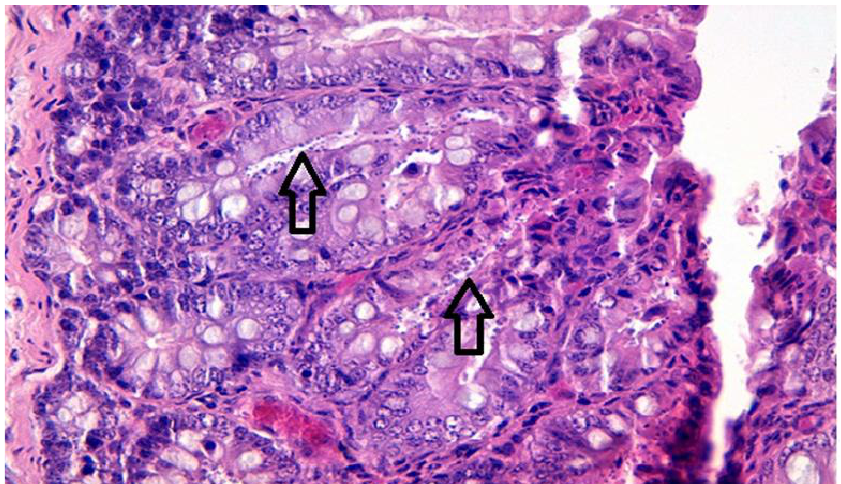
Figure 1. Fecal smear stained by the Ziehl Neelsen method. The smear shows a large number of oocysts belonging to the species C. parvum . The high density of oocysts confirms the cause of digestive disorders in the calves studied. The photography was carried out with the Leica DM 750 photon microscope at the ×1000 Immersion lens.